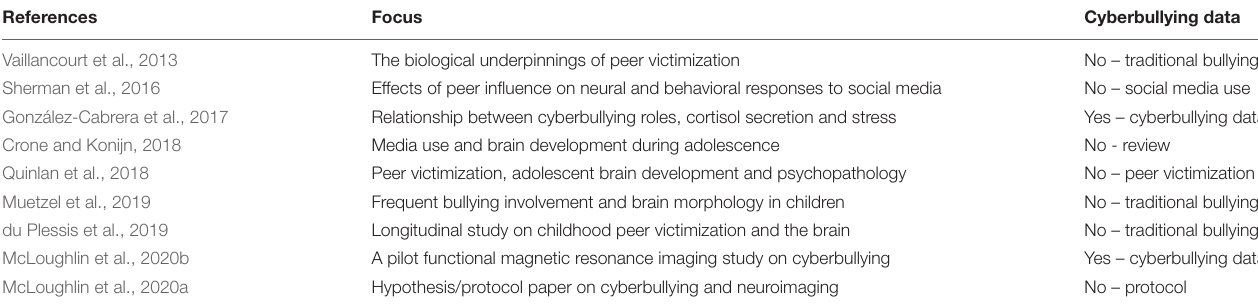
TABLE 1 | Studies that specifically addressed neurobiology, the brain, and cyberbullying or traditional bullying/social media